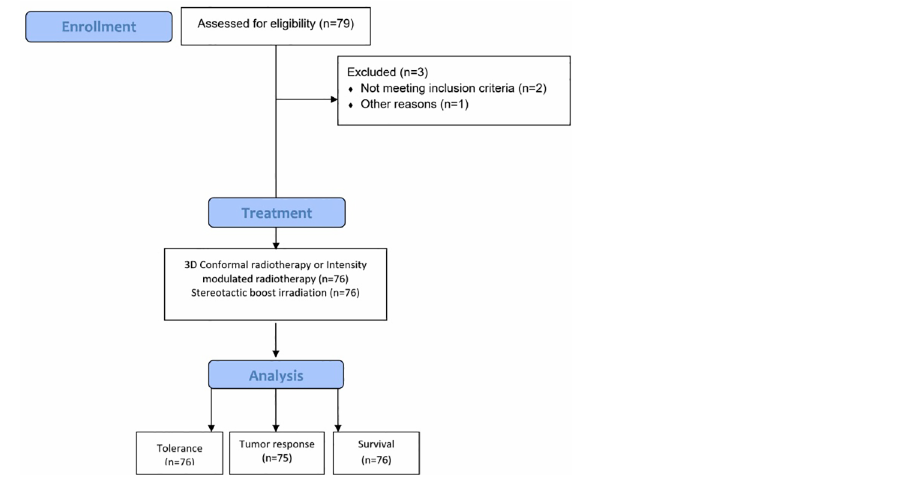
Fig 1. Flowchart diagram of the